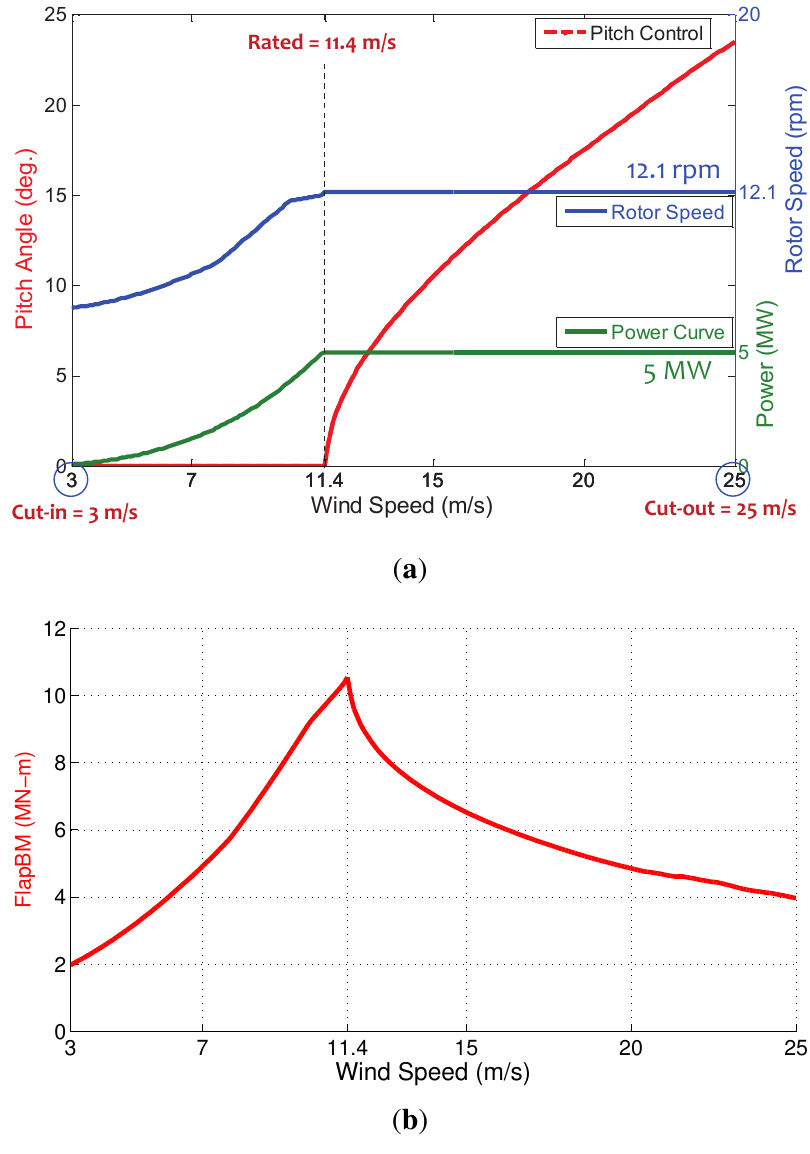
Figure 3. Steady state response. ( a ) Pitch control, rotor speed, and power curve; ( b ) Flapwise bending moment at a blade